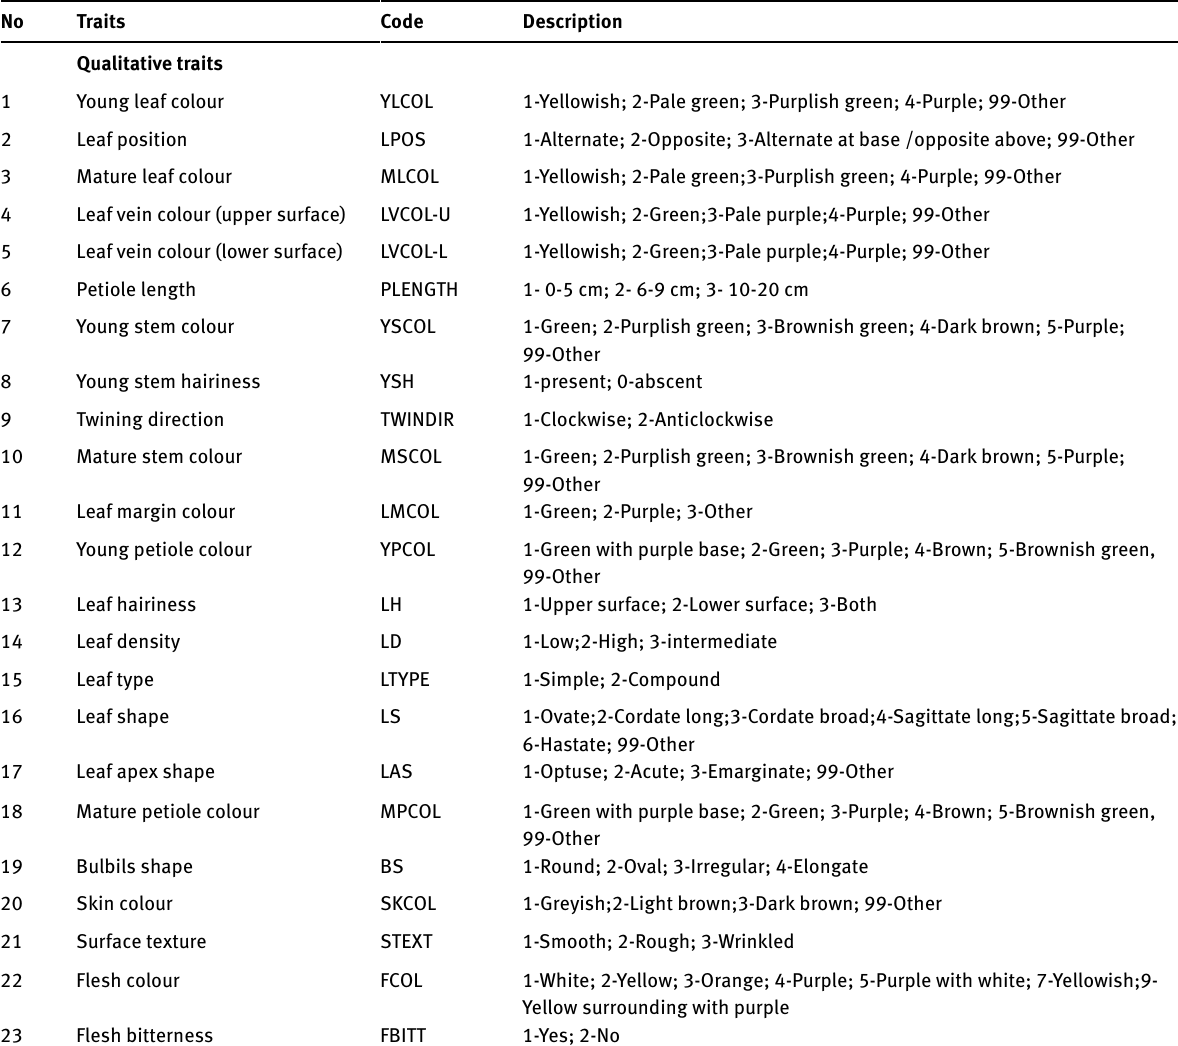
Table 2: List of qualitative and quantitative traits, their codes and their descriptions for Dioscorea bulbifera plants No Traits Code